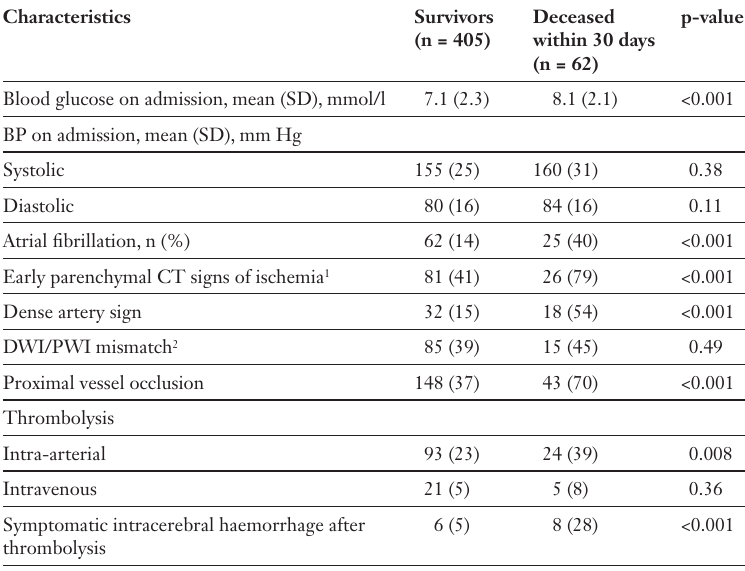
Ancillary Examinations and Thrombolysis in 467 patients with a first-ever ischaemic stroke. Characteristics